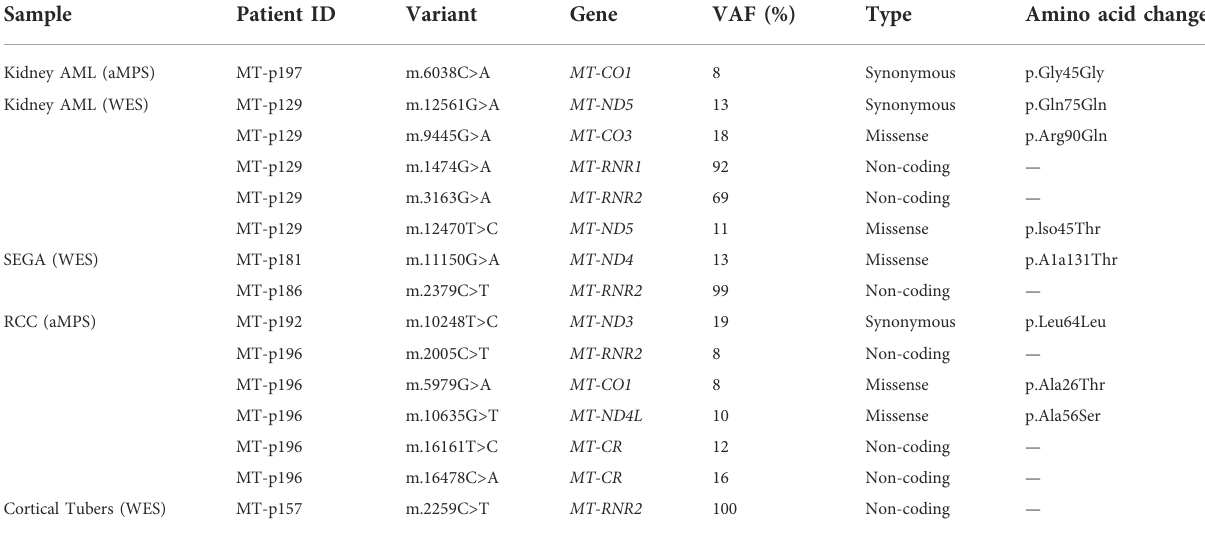
TABLE 3 Somatic mtDNA variants identi fi ed in TSC-associated tumor samples.